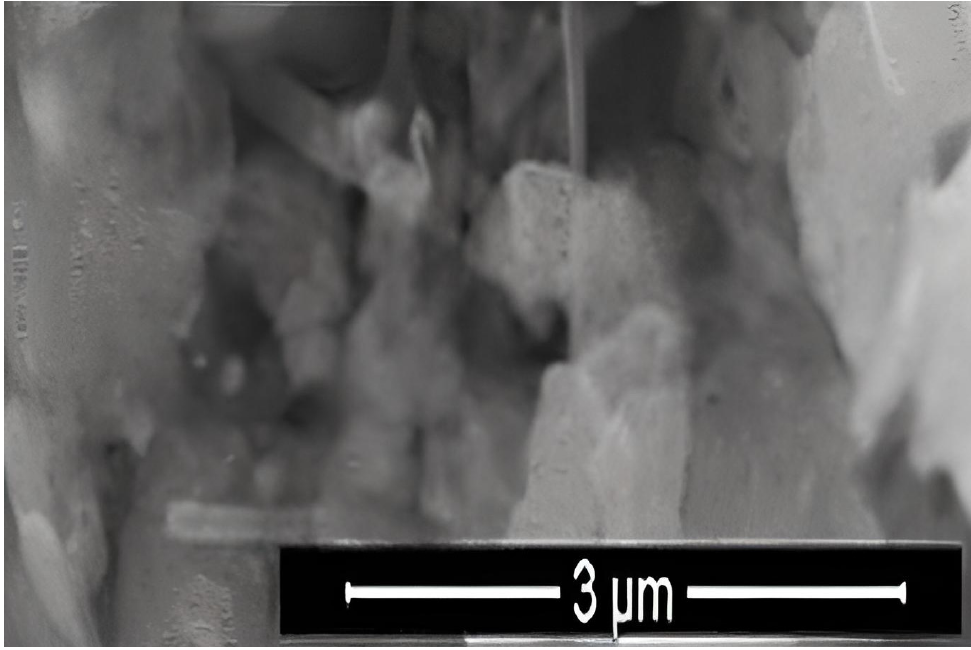
Figure 4. Scanning electron microscope (SEM) image (FEI inspect S50 SEM, 3 μ m scale) of Co 2 B NPs.